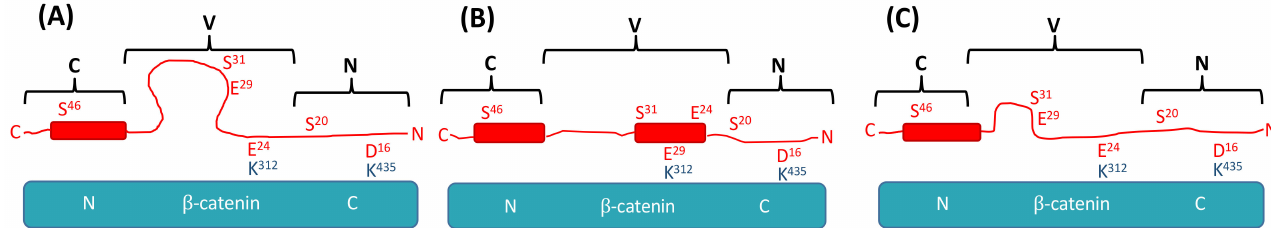
Figure 5. Schematic showing the three interface regions (N, variable (V), and C) of TCF7L2. The schematics show the conformational preferences of TCF7L2 (red) in complex with β -catenin (cyan) in the different crystal structures. ( A – C ) are based on the crystal structures of Poy et al. (PDB 1JPW, [22]), Graham et al. (1JDH, [20]), and Sampietro et al. (2GL7, [25]) , respectively. The N-terminal binding domain (N) and the C-terminal binding domain (C) each adopt very similar conformations in all three structures, but the variable region (V) had a different conformation in each